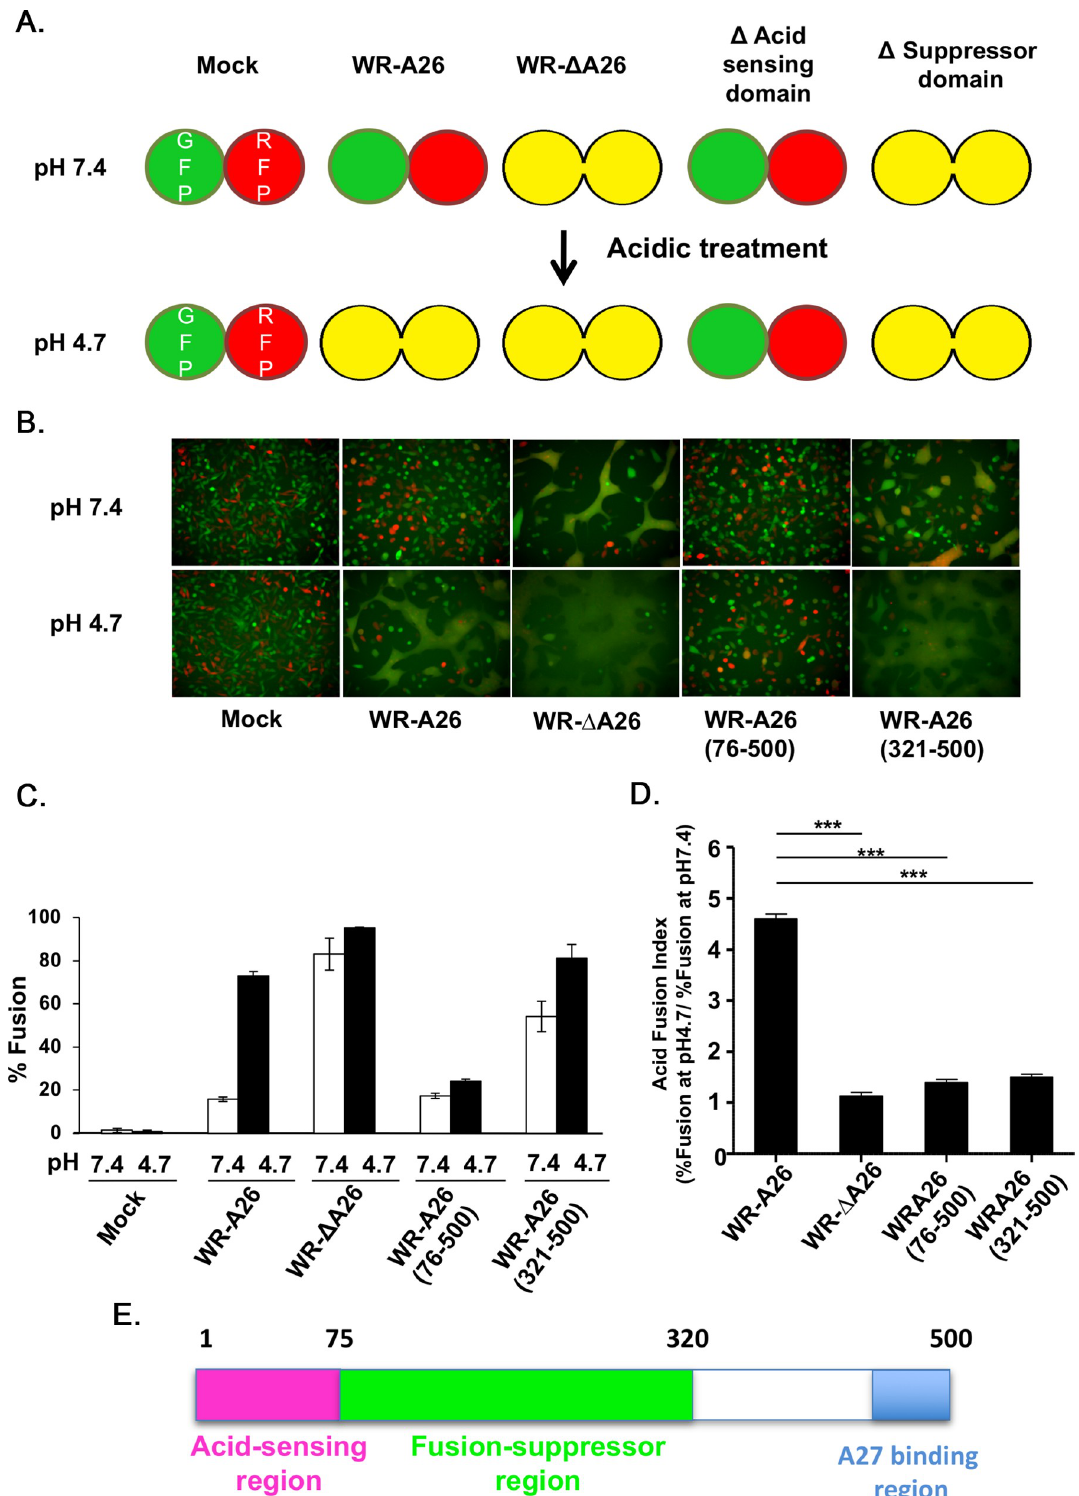
Fig 2. N-terminal region of A26 protein (aa 1–75) is important for endocytic-mediated MV membrane fusion at low pH. (A). Schematic presentation of vaccinia MV-dependent cell-cell fusion at neutral and acidic pH. L cells expressing GFP and RFP were mixed at a 1:1 ratio during seeding. No cell fusion occurs at either pH in the absence of infection (Mock). When cells were infected